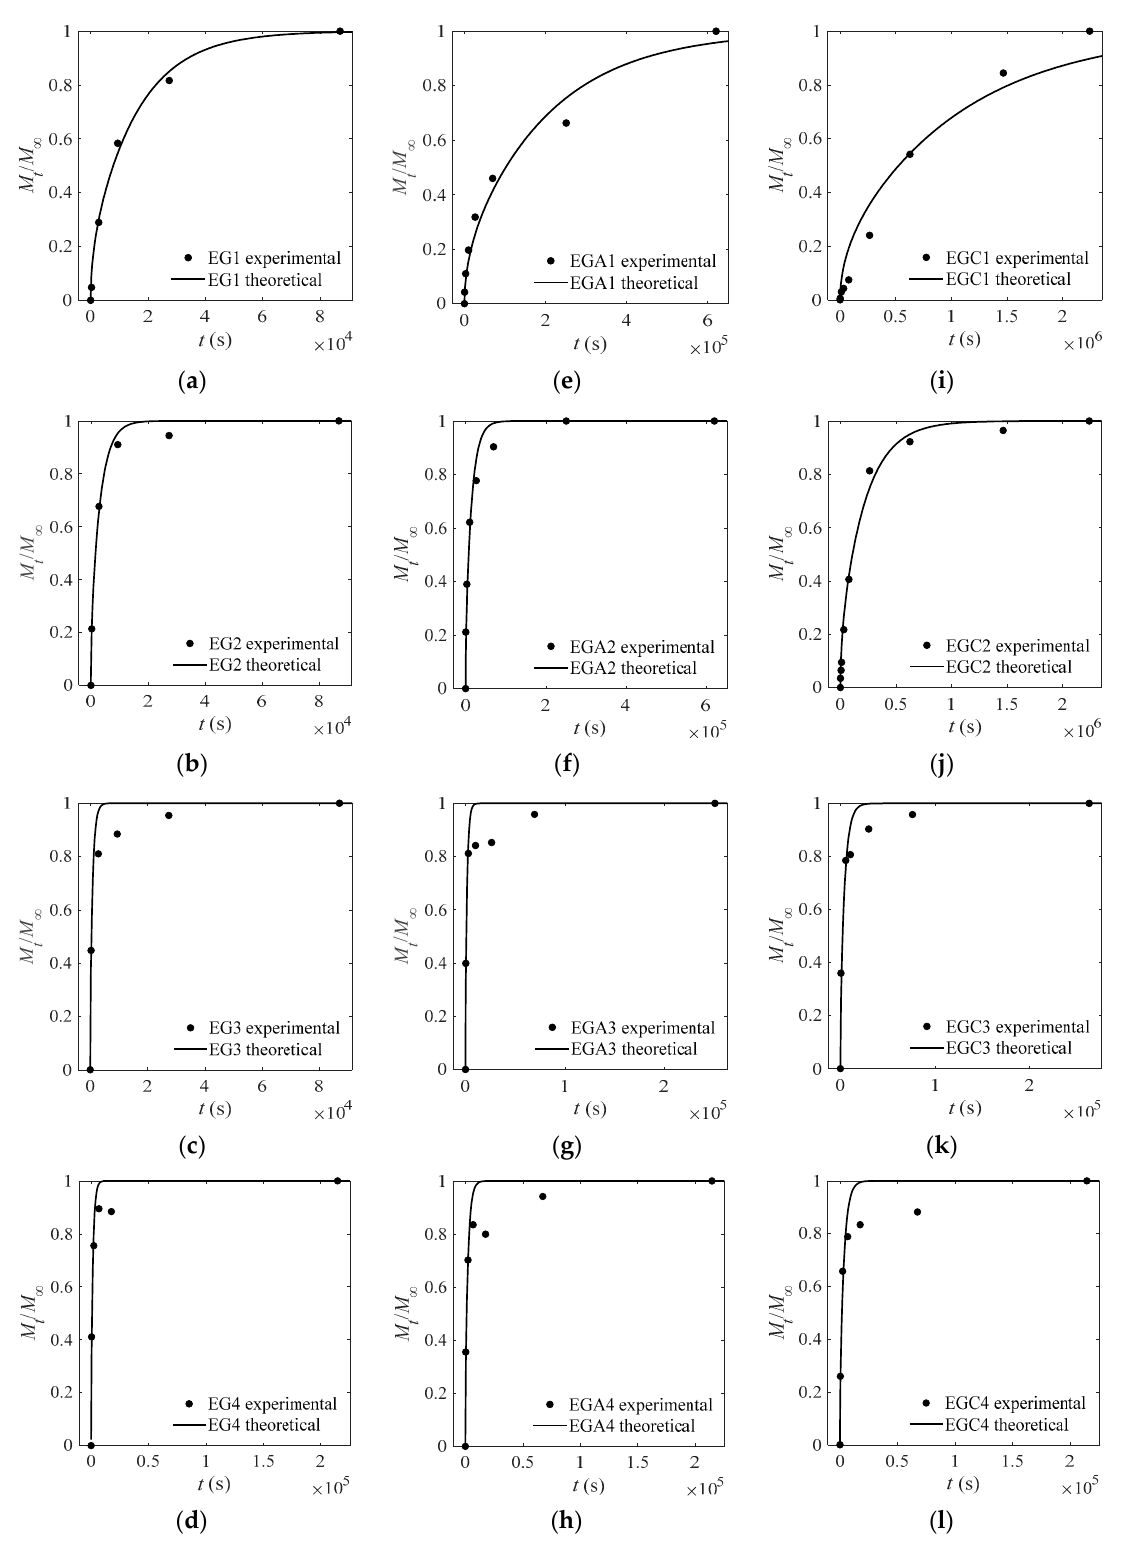
Figure 3. Experimental and theoretical values of one-way release tests of cinnamon essential oils (CEOs) released from films EG1–EG4 ( a – d ), EGA1–EGA4 ( e – h ), and EGC1–EGC4 ( i – l ) to absolute ethanol at 4 °C.